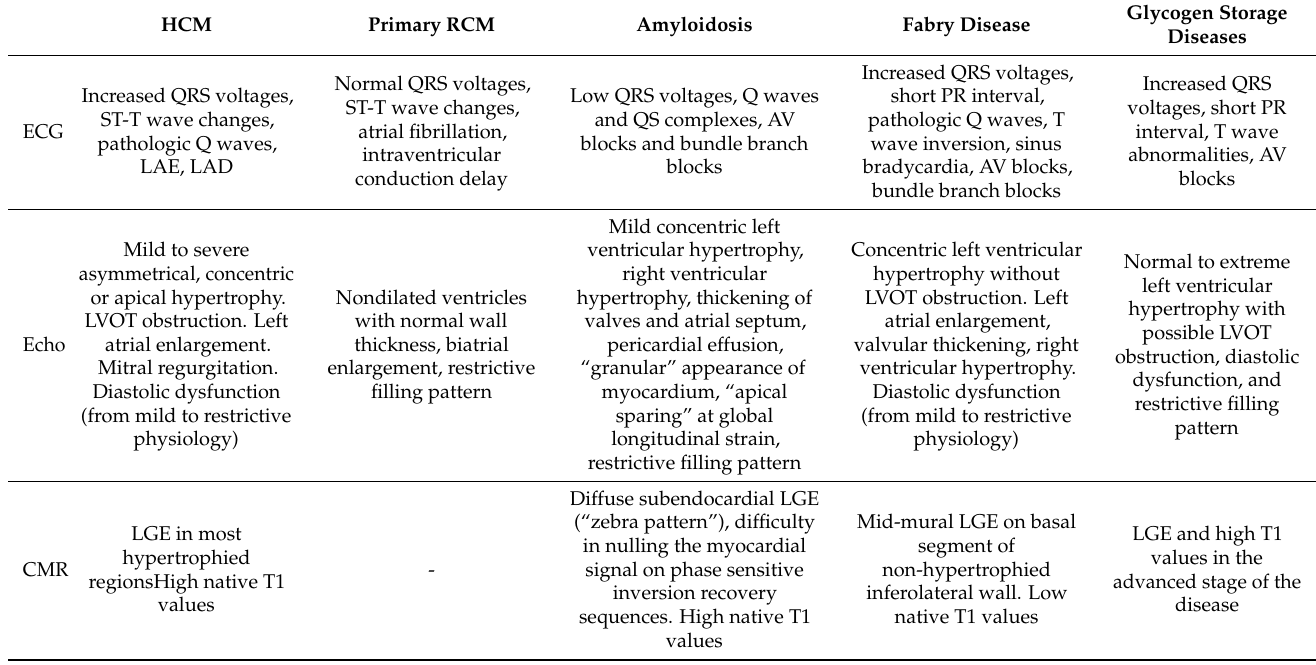
Table 2. Common diagnostic findings of hypertrophic cardiomyopathy, primary restrictive cardiomyopathy, amyloidosis, Fabry disease, and glycogen storage